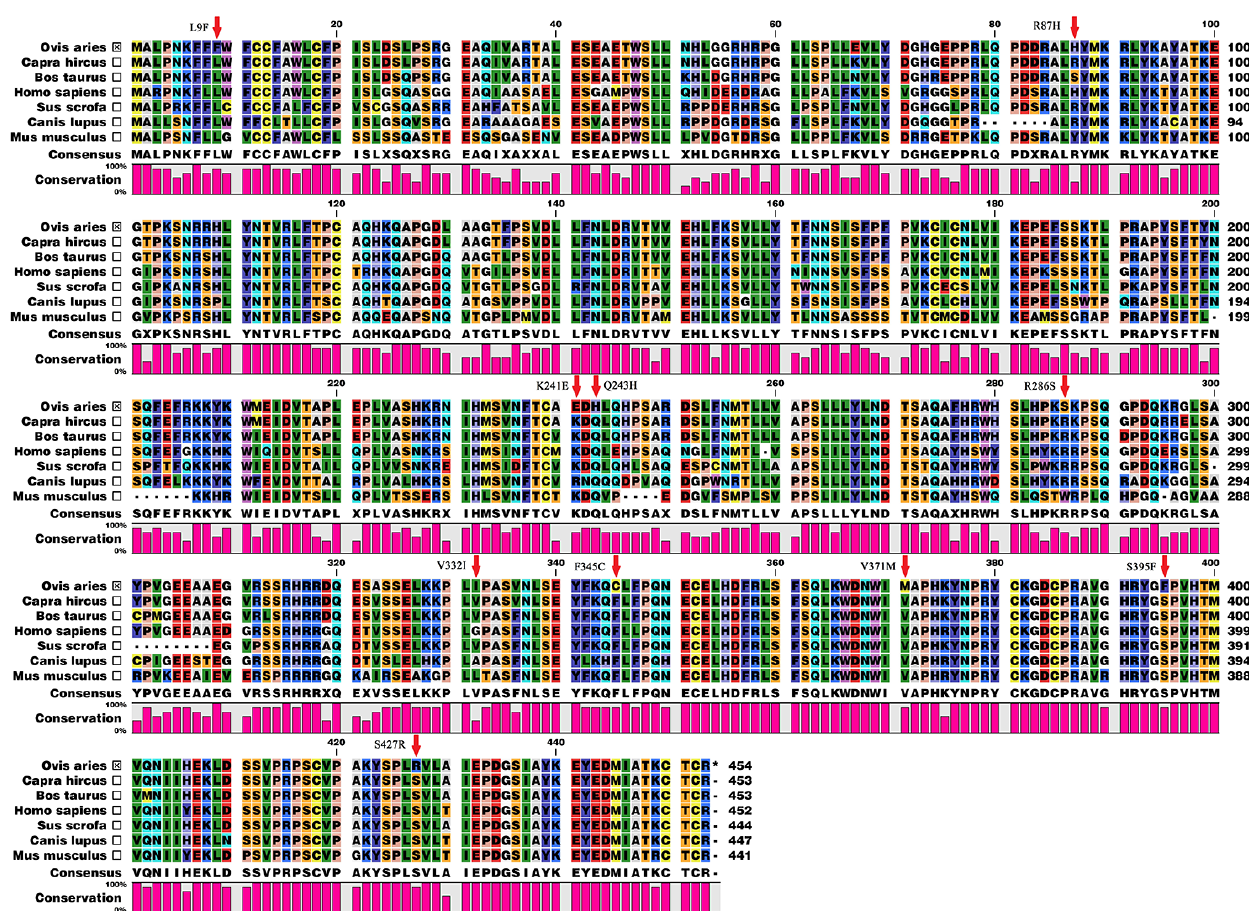
Figure 2. Multiple alignment of GDF9 propeptide sequence among sheep [NP_001136360.2], goats [NP_001272637.1], cattle [NP_777106.1], dogs [NP_001161485.1], wild boar [NP_001001909.1], humans [NP_001275754.1], and mice [NP_032136.2]. The amino acid changes due to the detected GDF9 mutations in sheep are illustrated by